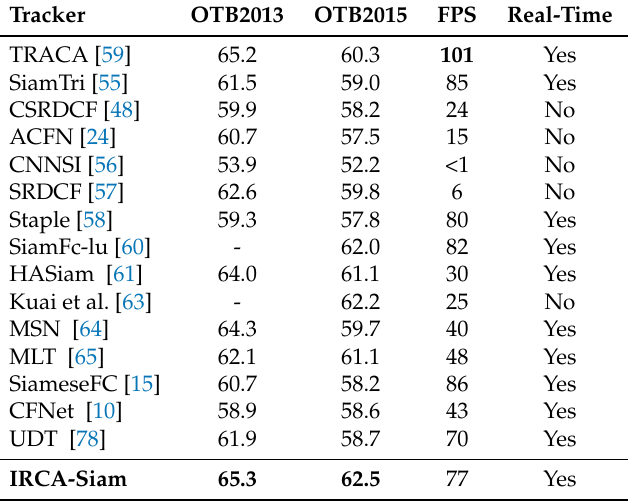
Table 1. Performance comparison of IRCA-Siam with other trackers over OTB2013 and OTB2015 using success and speed in